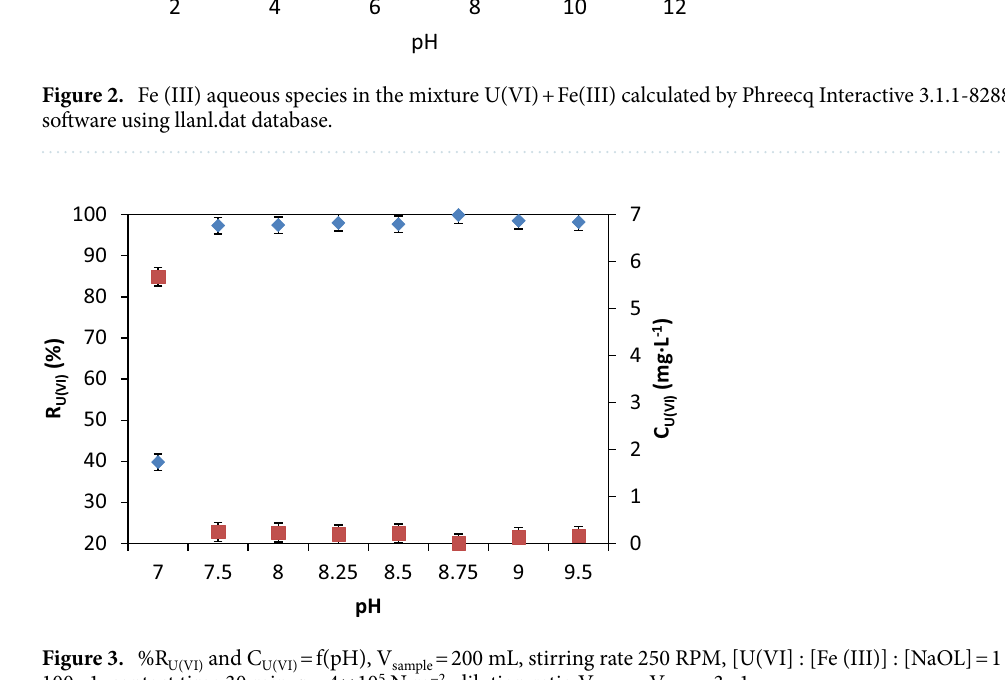
Figure 3. %R U(VI) and C U(VI) = f(pH), V sample = 200 mL, stirring rate 250 RPM, [U(VI] : [Fe (III)] : [NaOL] = 1 : 100 : 1, contact time 30 min, p = 4 × 10 5 N·m −2 , dilution ratio V sample : V water = 3 :